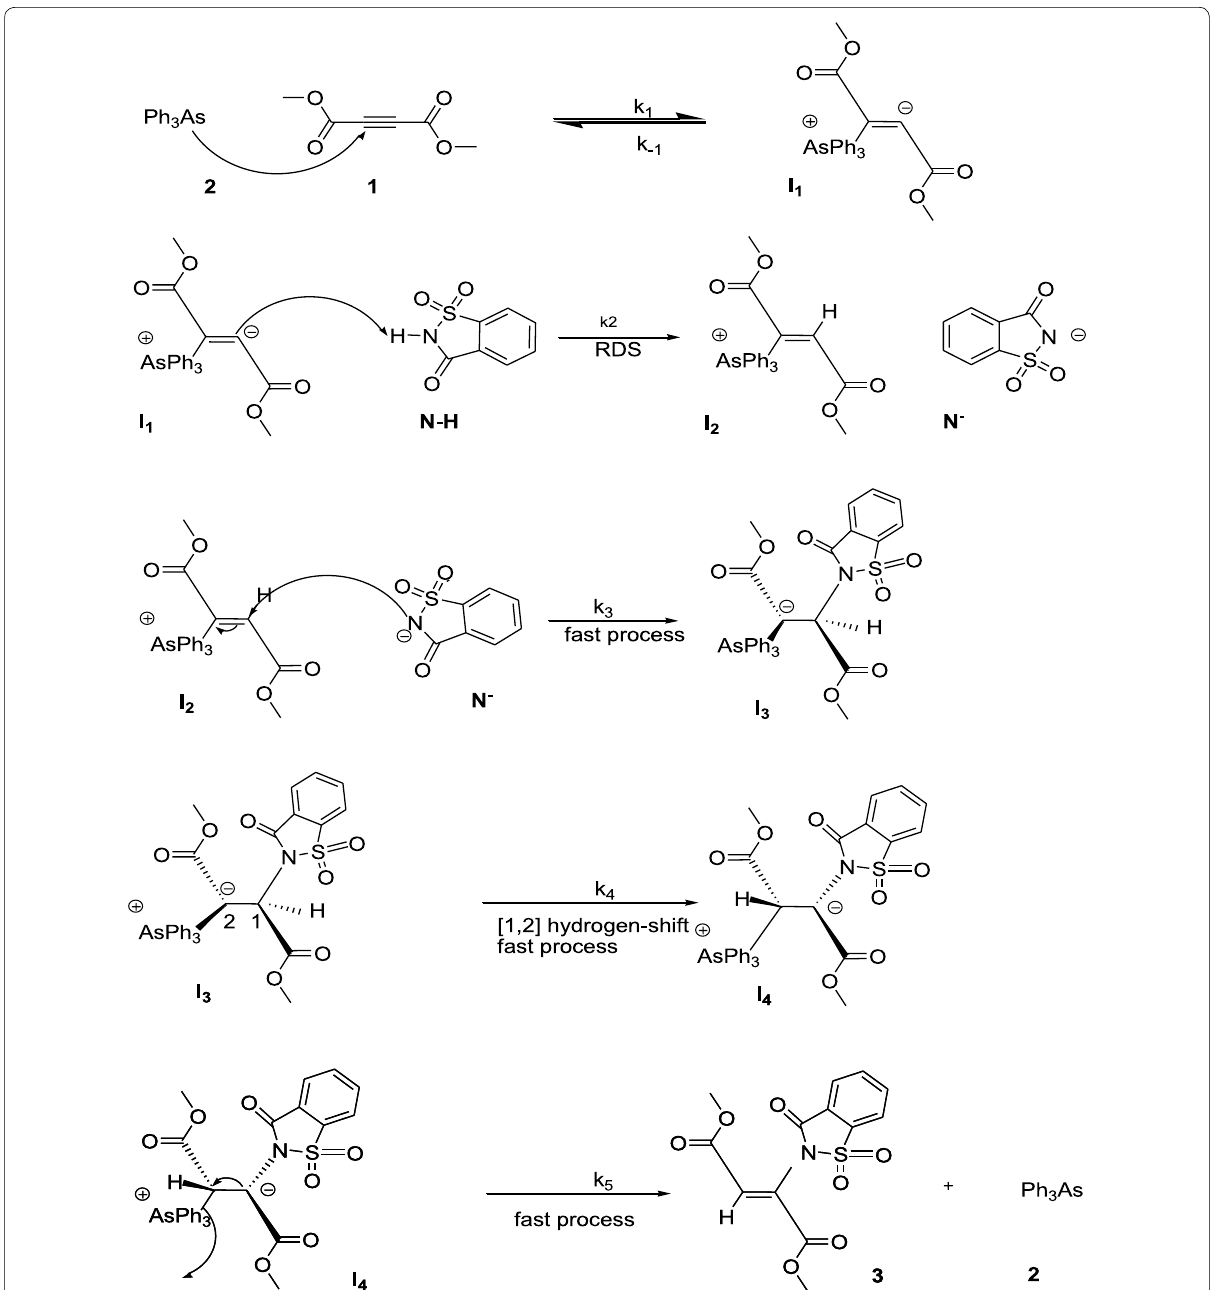
Fig. 10 Speculative mechanism for the reaction between ( 1 ) and ( N – H ) compound (saccharin)in the presence of a catalyst ( 2 ) for generation of N‑vinyl heterocyclic compound 3 in